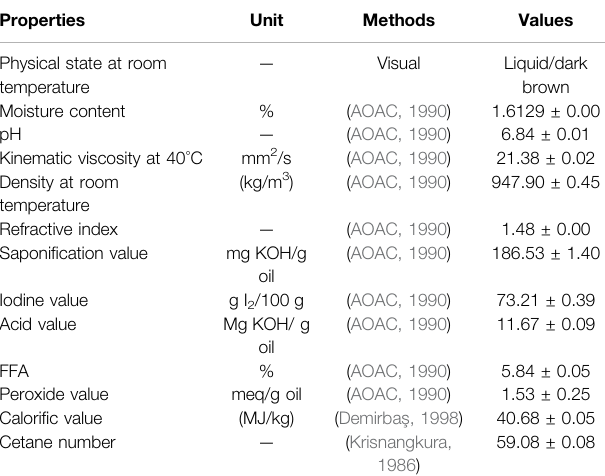
TABLE 4 | Physical and chemical properties of crude